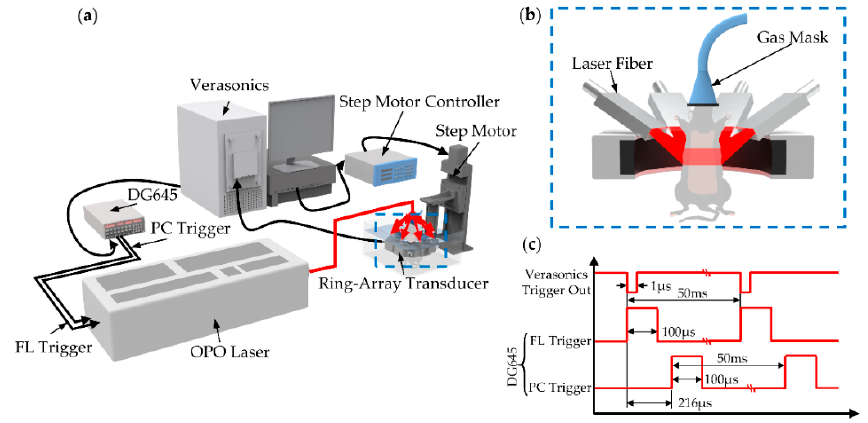
Figure 1. System structure schematic and trigger timing diagram. ( a ) Schematic of the dual-wavelength PACT system for tumor imaging; ( b ) Close up of the blue dashed box region in ( a ), which shows the distribution of the laser fibers and the placement of mouse; ( c ) System trigger timing diagram.